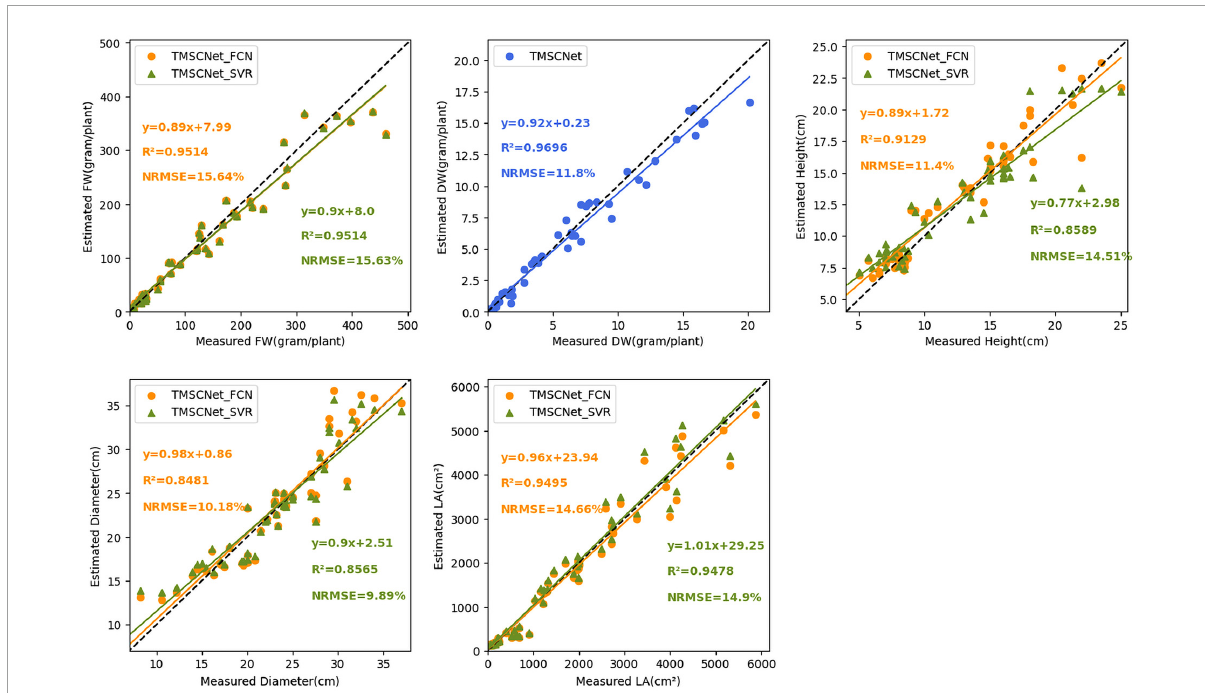
FIGURE12 Estimation result of lettuce traits based on TMSCNet with different self-correcting models. TMSCNet_SVR uses SVR as self-correcting models. TMSCNet_FCN adopts FCN as self-correcting models. Among them, the network takes FCN as the self-correcting model.